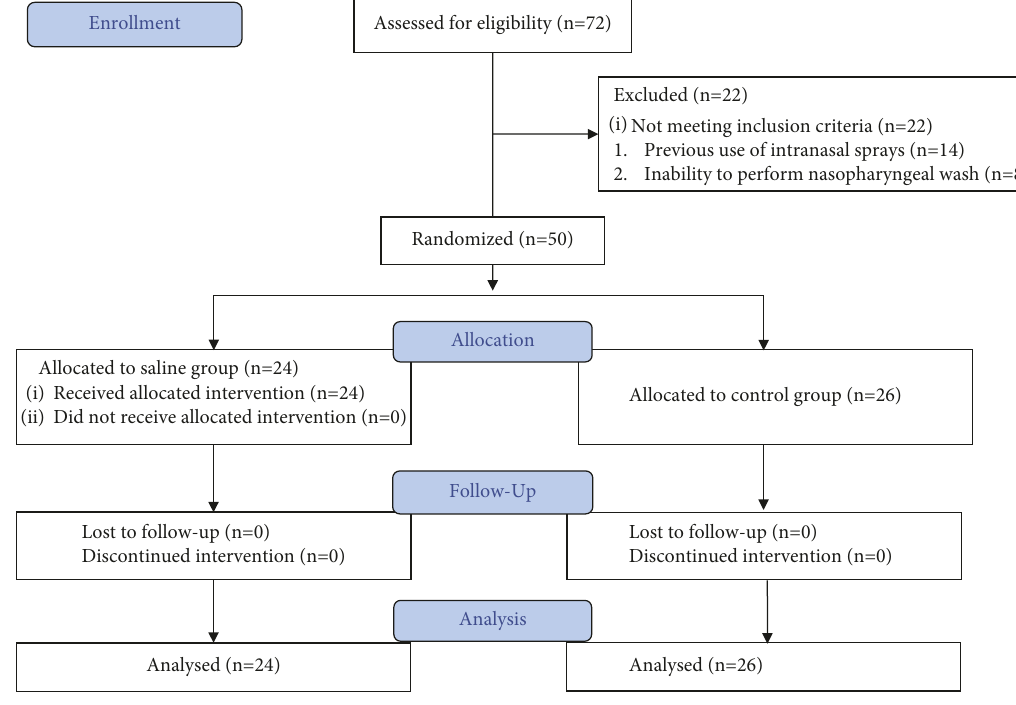
Figure 1: Consort flow diagram of the study. Table 1: Baseline characteristics of the population